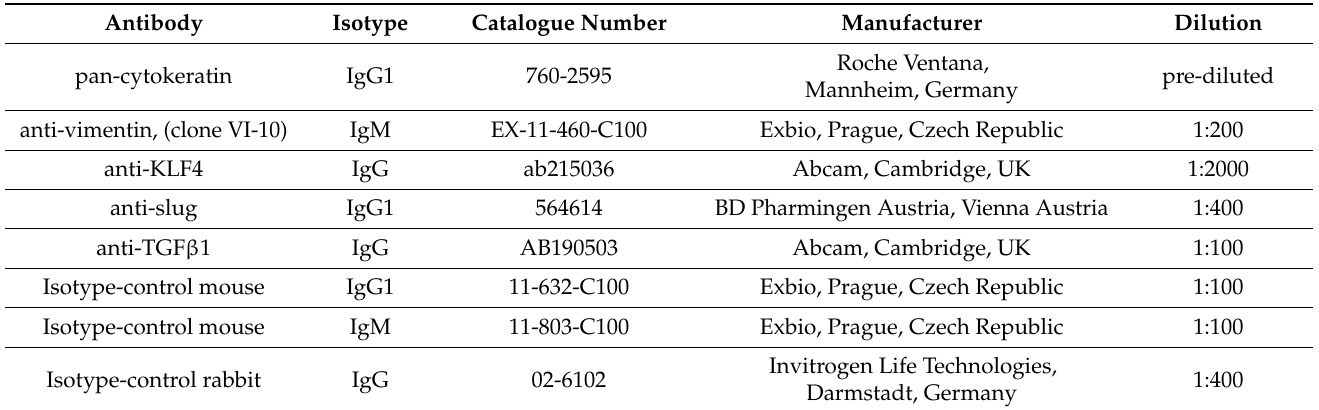
Table 2. Overview of primary antibodies for immunohistochemistry and immunofluorescence